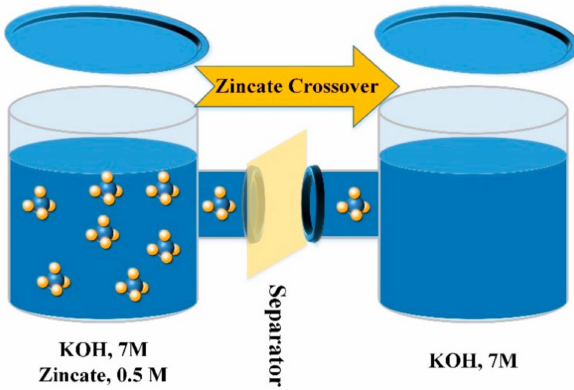
Figure 11. Schematic view of the di ff usion cell used to measure zincate